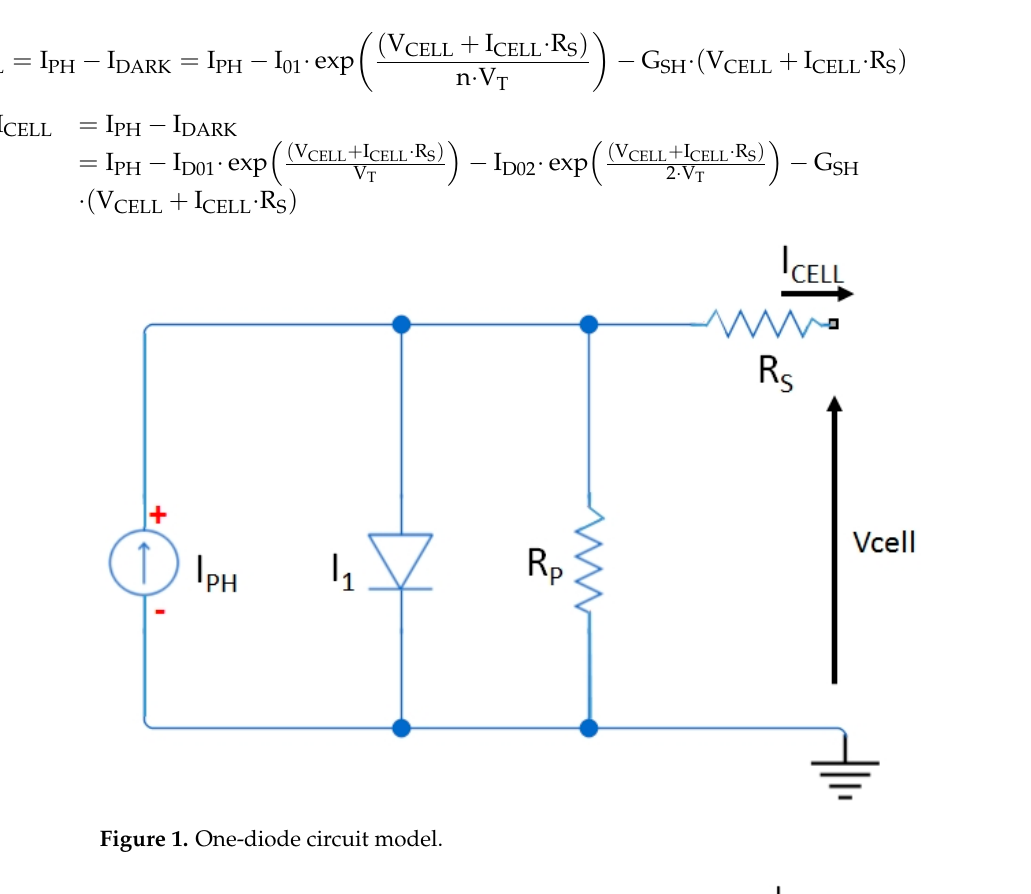
Figure 1. One-diode circuit model.